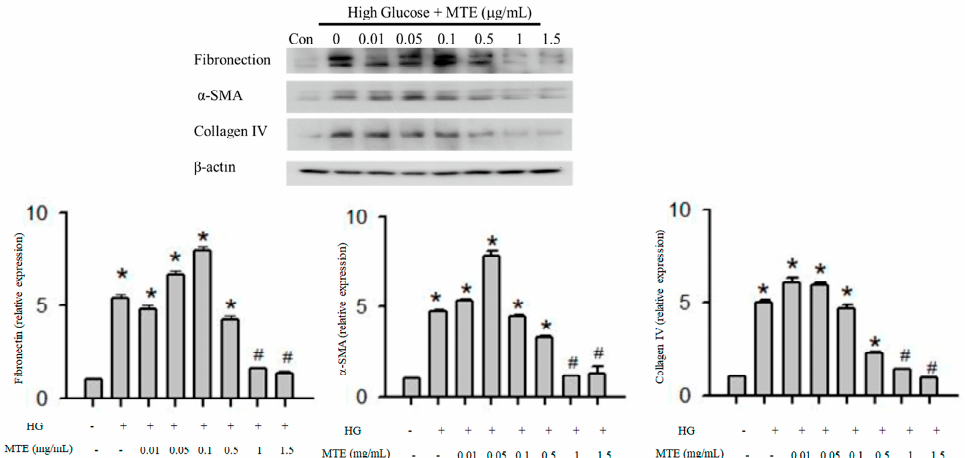
Figure 2. MTE mitigated the expression of fibrosis-related proteins in diabetic mice. The mouse renal mesangial cells were treated with 0, 0.01, 0.05, 0.1, 0.5, and 1 and μ g/mL MTE in the presence of high glucose for 48 h. Cells in the absence of high glucose were used as a negative control (Con). Proteins were extracted and subjected to Western blot analysis (upper panel). b-actin was used as a loading control. Lower panel: the data represent the means and standard error obtained from at least three independent experiments. *: p < 0.05 compared to the control group. #: p < 0.05 compared to the db/db